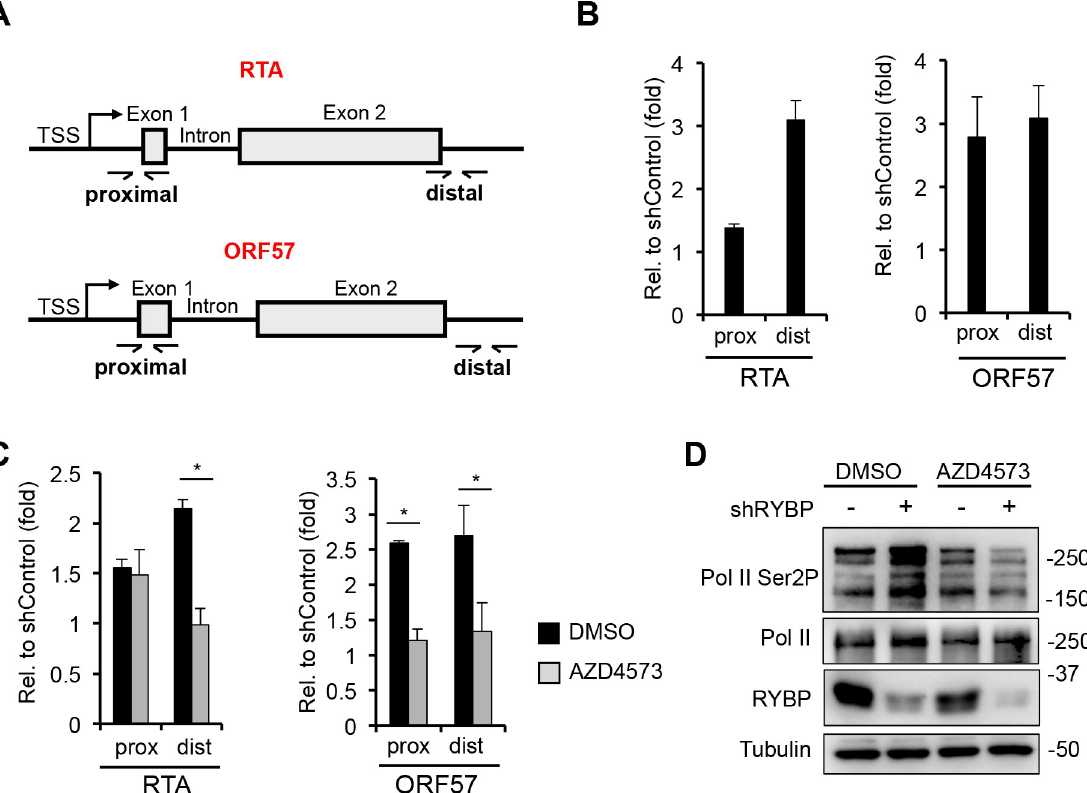
Fig 7. The effect of RYBP on transcription initiation and elongation at viral genes. (A) Schematic representation of the structure of RTA and ORF57 genes. The location of RT-qPCR primers targeting the proximal (prox) and distal (dist) regions are indicated. (B) SLK cells were transduced with shControl- and shRYBP-expressing lentiviruses for 72 hours, followed by KSHV infection for 8 hours. RT-qPCR analysis of viral mRNA levels at the proximal and distal gene regions of RTA and ORF57 upon RYBP depletion relative to shControl. (C) shControl- and shRYBP-treated SLK cells were treated with 30 nM AZD4573 and infected with KSHV for 8 hours. RT-qPCR analysis of viral mRNA levels at the proximal and distal gene regions of RTA and ORF57 upon RYBP depletion relative to shControl samples. The t- test was performed between DMSO-treated and AZD4573-treated shRYBP samples and p < 0.05 ( � ) was considered statistically significant. (D) Immunoblots analysis of RYBP and Pol II expression as well as Ser2 phosphorylation levels of Pol II.